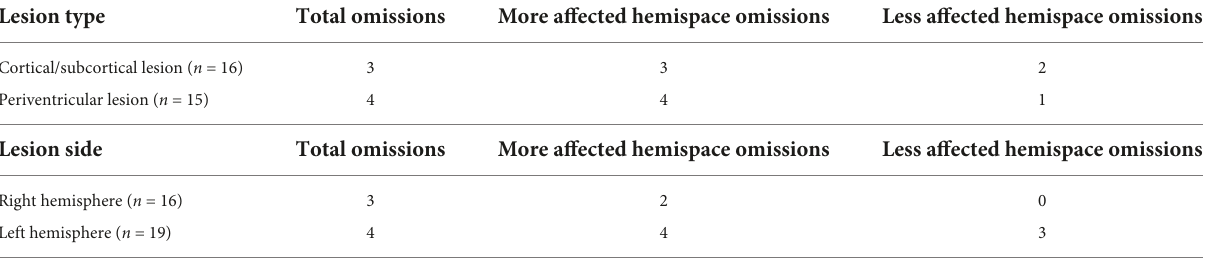
TABLE 3 Amount of children presenting impaired visuospatial